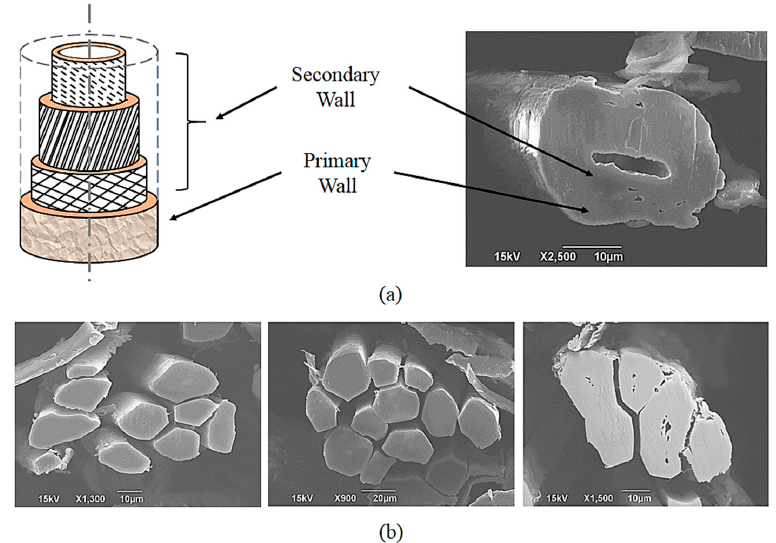
Figure 1. ( a ) The structure of a flax fiber cell; ( b ) cross-section of a bundle of flax fibers.